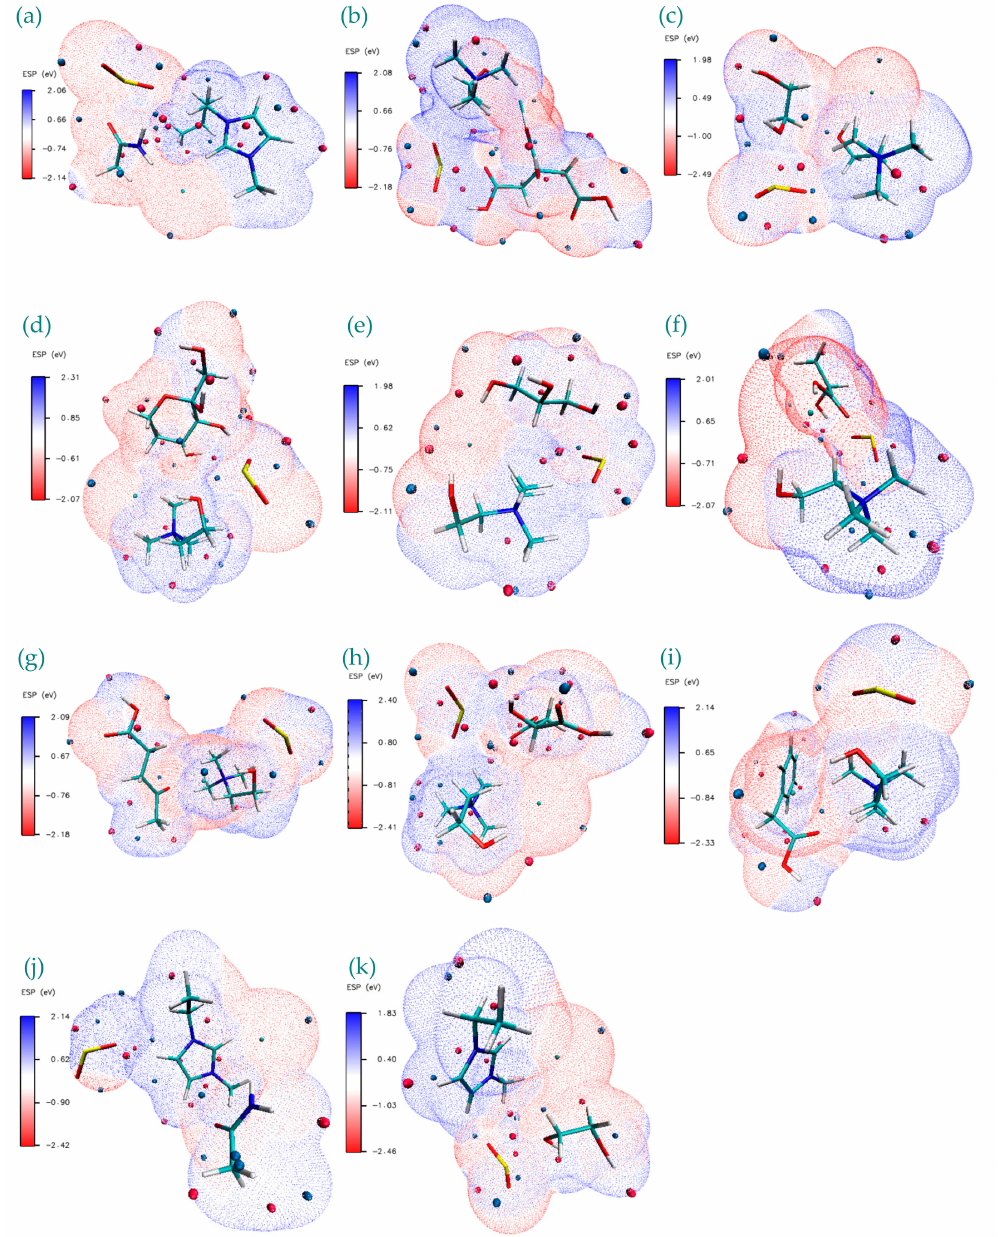
Figure 7. Electrostatic potential (ESP) surface map visualization for studied DES + SO 2 structures. Blue, white and red correspond to ESP varying from min to max level, the blue and red spheres correspond to ESP surface minima and maxima, respectively. ESP ranges are included in the legend at each figure panel. ( a ) Bmim:Ac + SO 2 , ( b ) ChCl:Ca + SO 2 , ( c ) ChCl:Eg + SO 2 , ( d ) ChCl:Fr + SO 2 , ( e )ChCl:Gy + SO 2 , ( f ) ChCl:La + SO 2 , ( g ) ChCl:Lv + SO 2 , ( h )ChCl:Ma + SO 2 , ( i ) ChCl:Pa + SO 2 , ( j ) Emim:Ac + SO 2